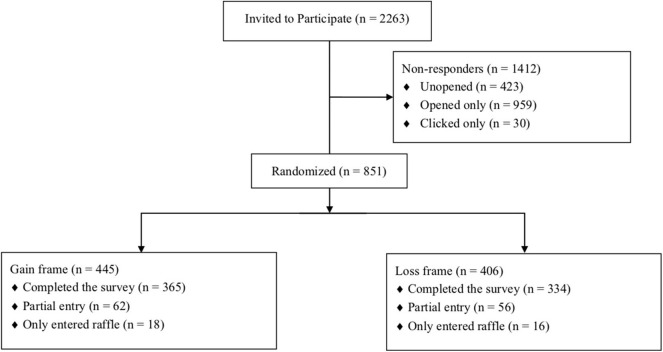
Attrition flow diagram showing the disposition of participants.